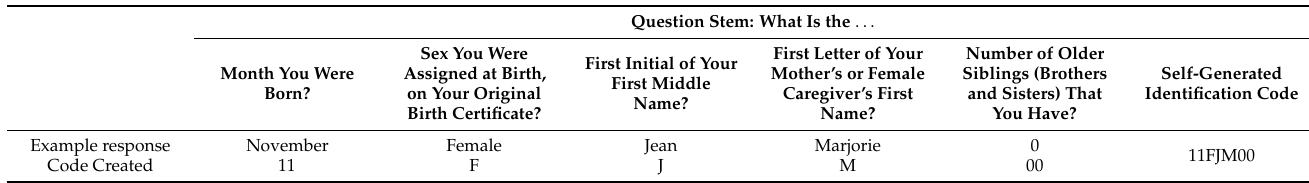
Table 2. Example of self-generated identification code.